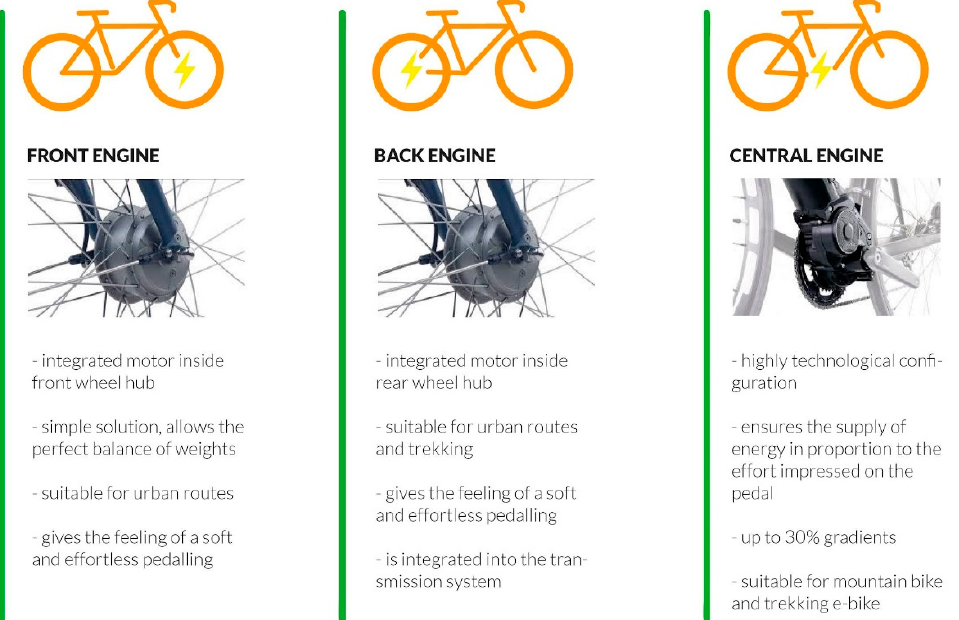
Figure 5. Types of engine